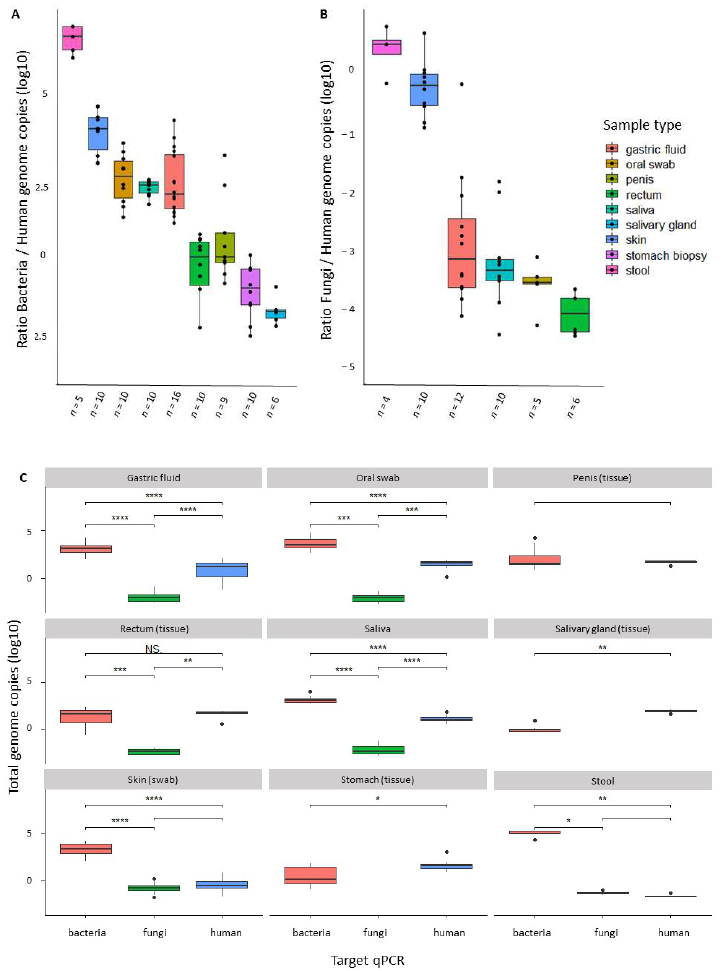
Figure 3. Genome-ratios for bacteria:human ( A ) and fungi:human ( B ) and total genome copies for bacteria (red), fungi (green) and human (blue) ( C ) in different human sample types. Mann–Whitney test * p < 0.05; ** p < 0.01; *** p < 0.001; **** p < 0.0001 significant.